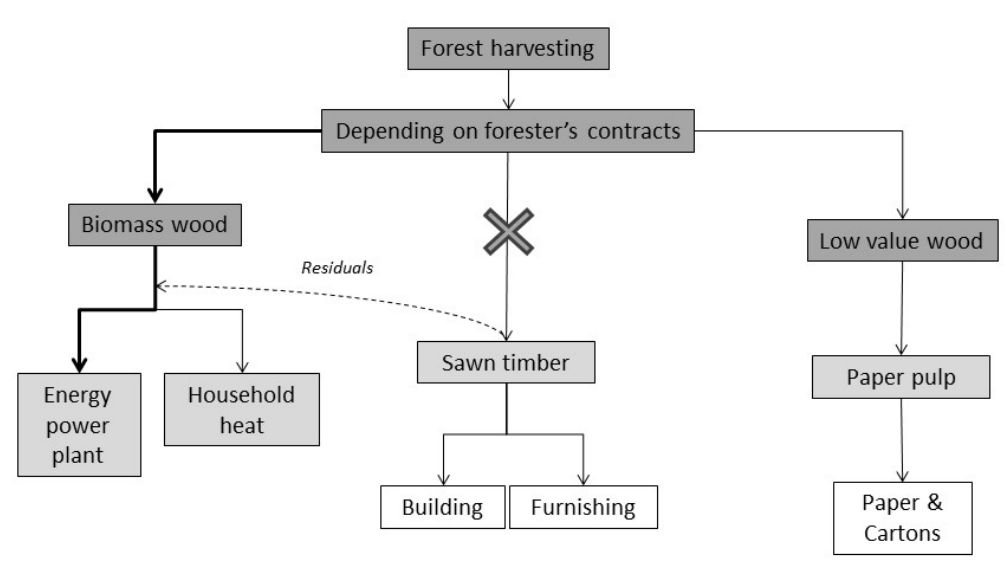
Figure 4. Description of an altered forestry sector with a domination for the biomass wood production. In this case, woods are not still sorting according to their value but according to the forester’s contracts with industries.